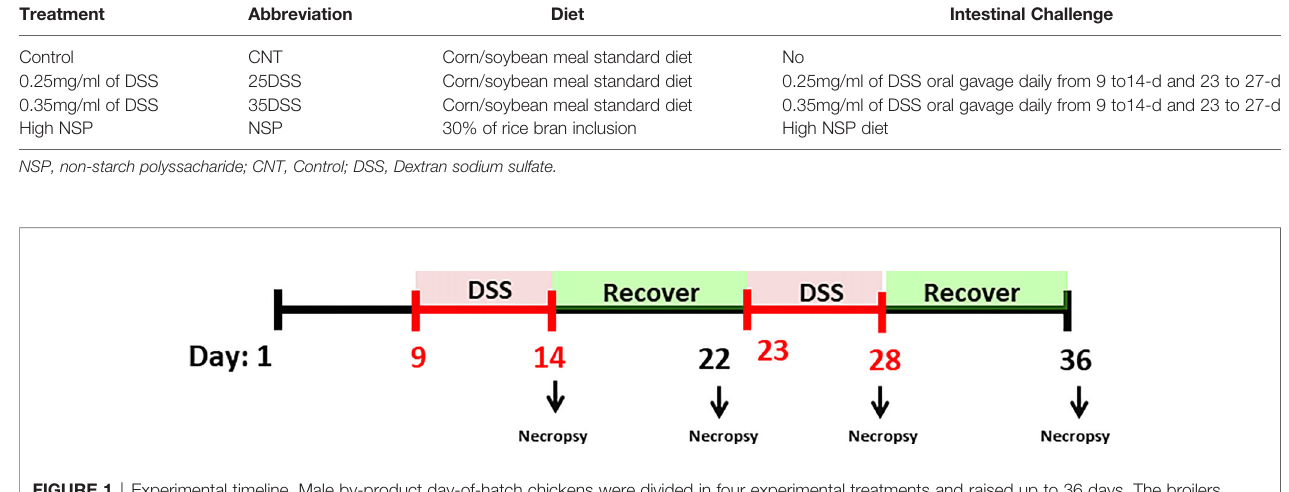
FIGURE 1 | Experimental timeline. Male by-product day-of-hatch chickens were divided in four experimental treatments and raised up to 36 days. The broilers assigned to treatments with DSS challenge received 0.25mg/ml or 0.35mg/ml of DSS via oral gavage everyday from 9 to 14-d and 23 to 27-d (induction phase period represented with red). After each DSS cycle animals were allowed to a 9 days recovery period (from 14 to 23-d and 27 to 36-d, marked in green). Birds in the NSP treatment received a diet with 30% of rice bran from 1 to 36-d. Animals in the control group were not submitted to any challenge. Necropsies were performed on days 14, 22, 28 and 36 for collection of intestinal tissue, blood, and fecal